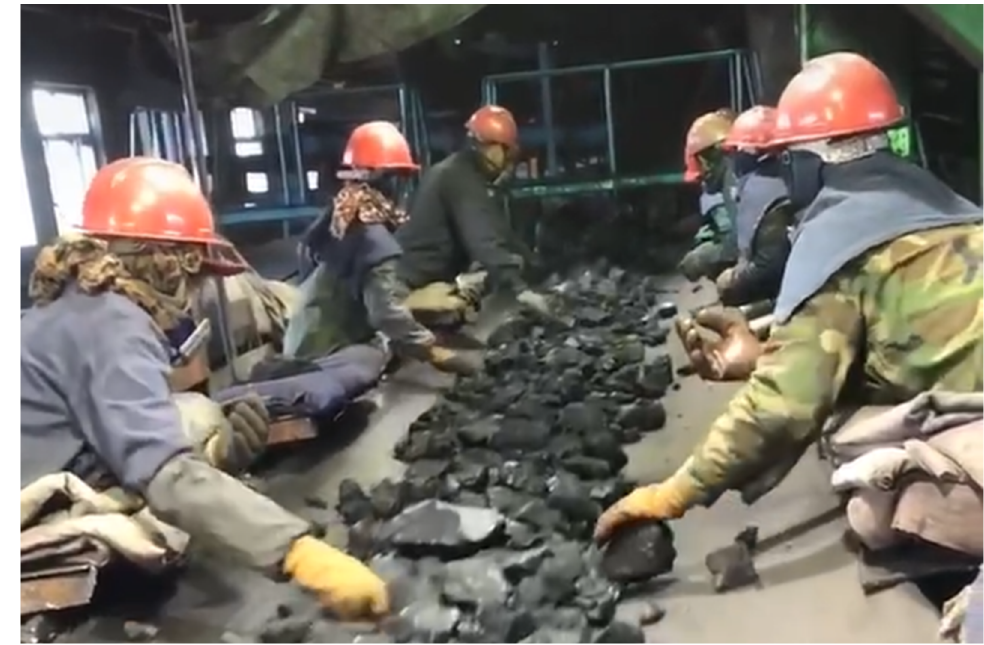
Figure 1. Scene depicting manual selection.